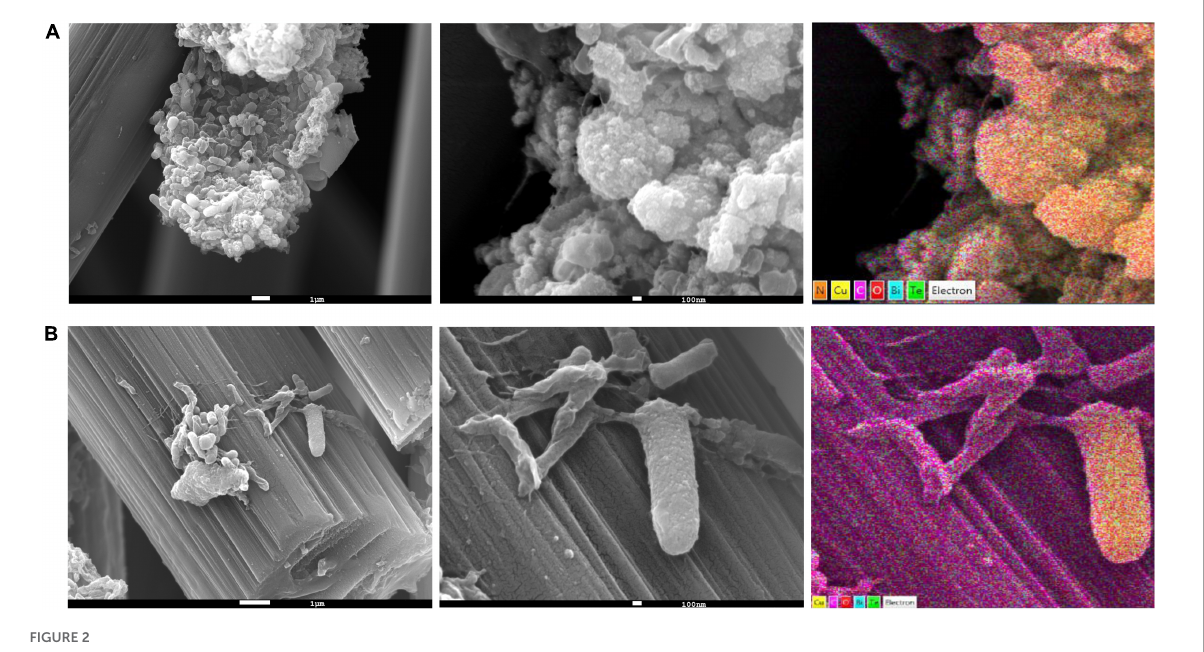
FIGURE2 Scanning electron microscopy (SEM) and energy-dispersive spectroscopy (EDS) elemental mapping of anodic biofilms from the (A) pH 4 (B) and pH 7 electrodes.